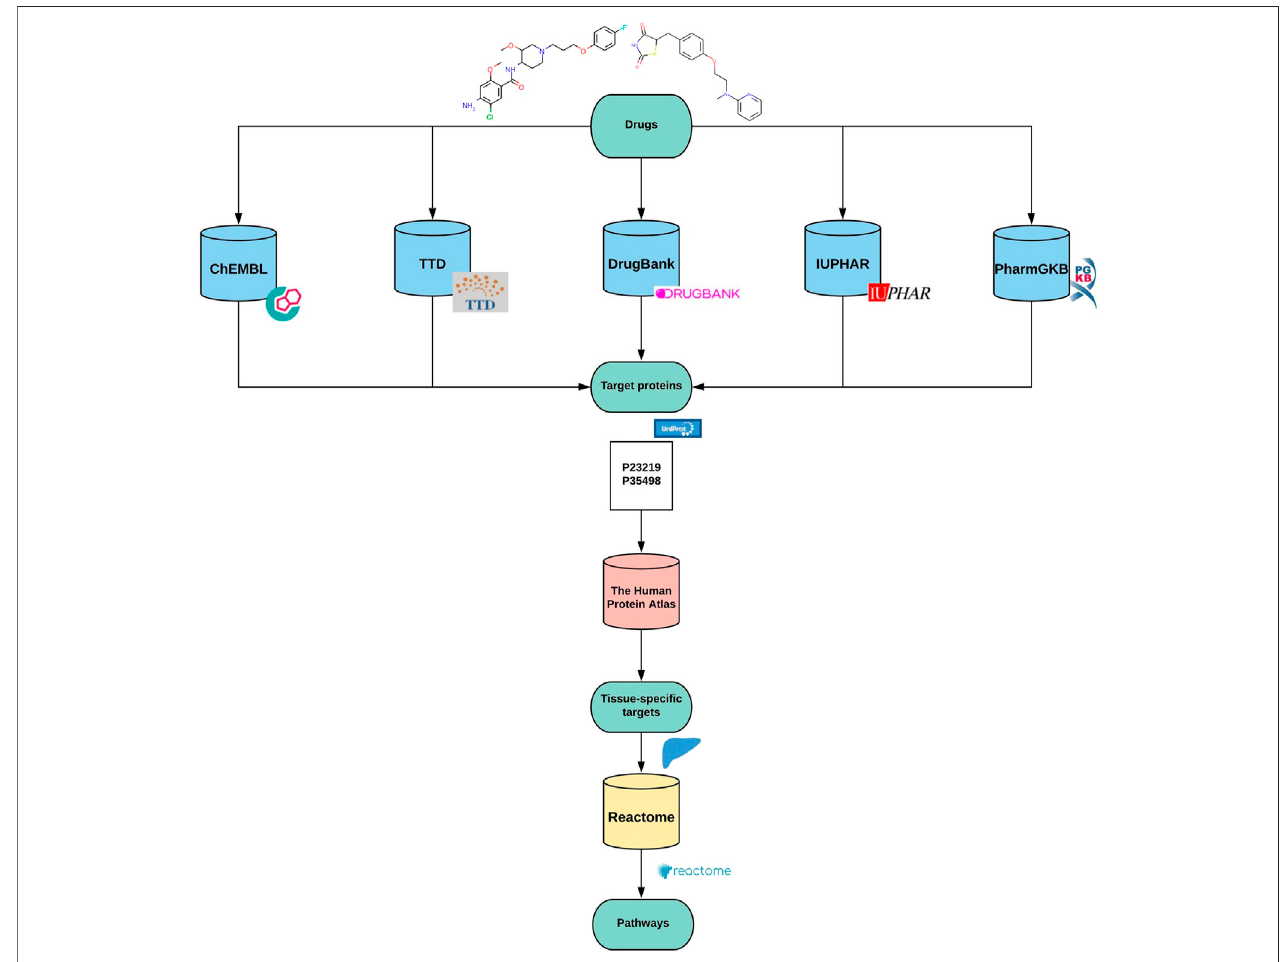
FIGURE 1 | Graphical overview of the